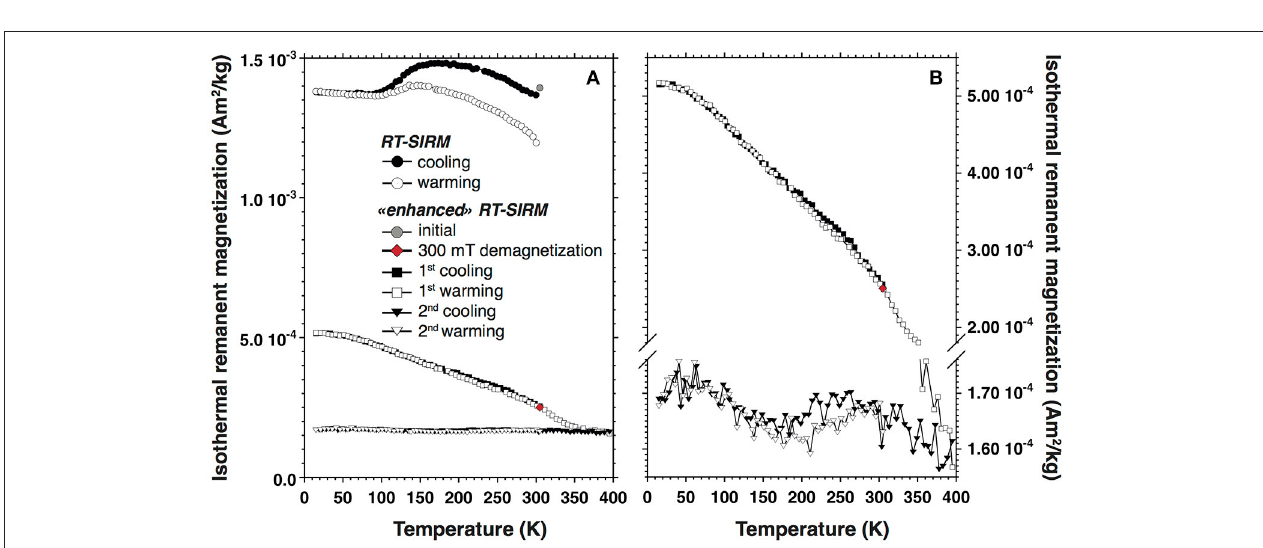
FIGURE 5 | The same experimental protocol as in Figure 4 conducted on a natural loess sample from the penultimate glaciation (Saalian) recovered in the Dolni Vestonice sequence in the Czech Republic. Full experiment is shown in (A) and a zoomed view of the first and second enhanced RT-SIRM cycles are shown in (B)